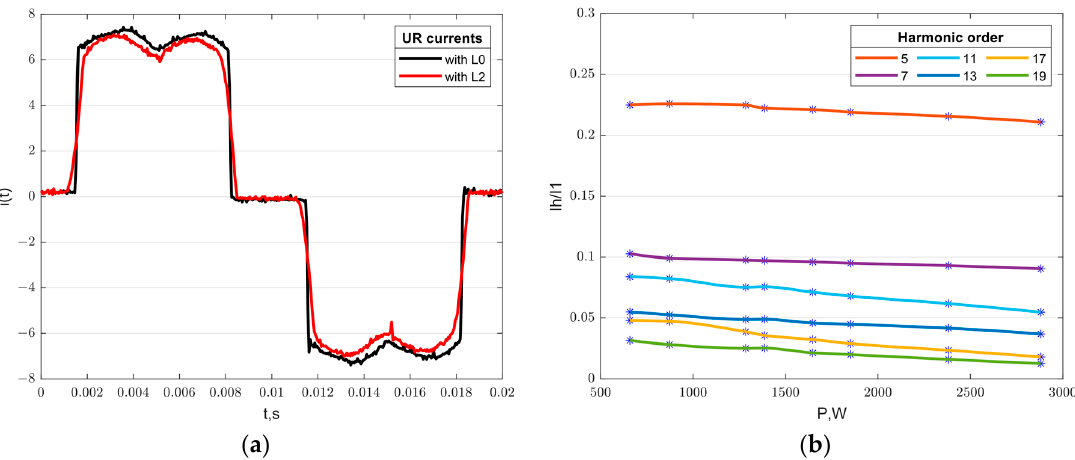
Figure 3. Waveforms of the UR currents at various values of the grid inductance ( a ); relative values of the UR harmonic currents for different power consumption ( b ).